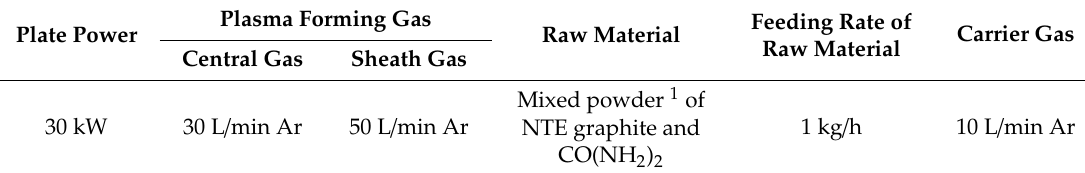
Table 1. Experimental conditions for the purification and N doping of nanothin exfoliated (NTE) graphite.